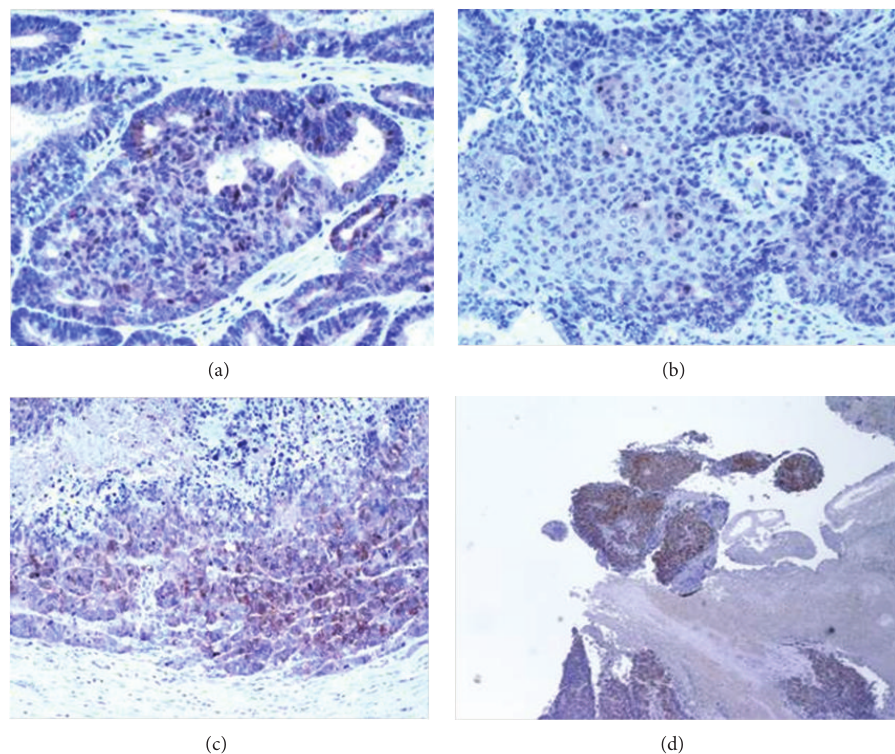
Figure 3: Poorly differentiated malignant neoplasm at histology: large cells, with scanty cytoplasm, hyperchromatic nuclei (a), uncohesive, diffusely dispersed, and occasionally disposed in tubular structures (c). The tumor shows being mostly necrotic with vital cells clasped around vessels (b). Immune-staining revealing a positive reaction for vimentin (+++) and CD99 (+++) (d). Proliferative index Ki67 is approximately